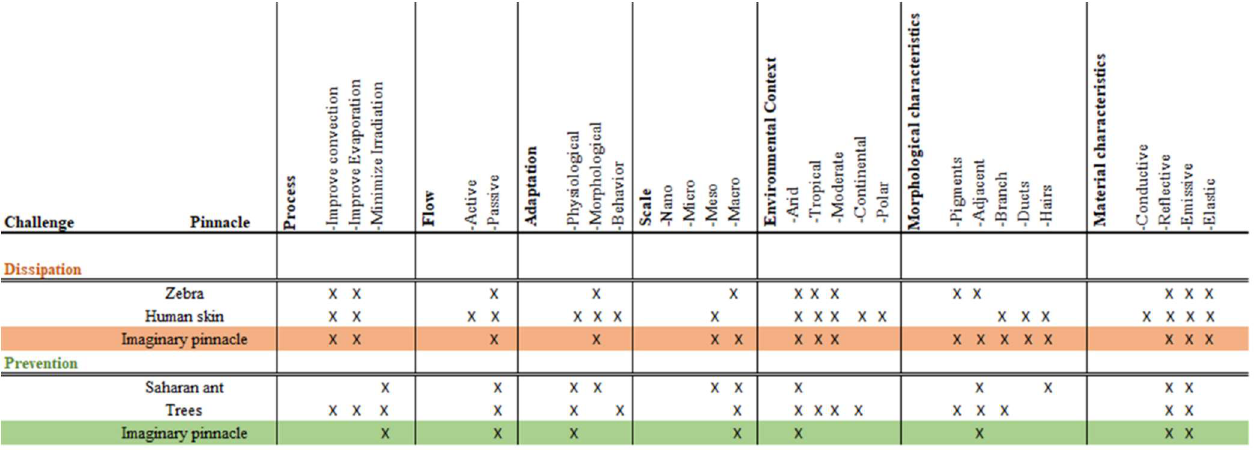
Figure 6. Pinnacles analysis matrix. Own elaboration.